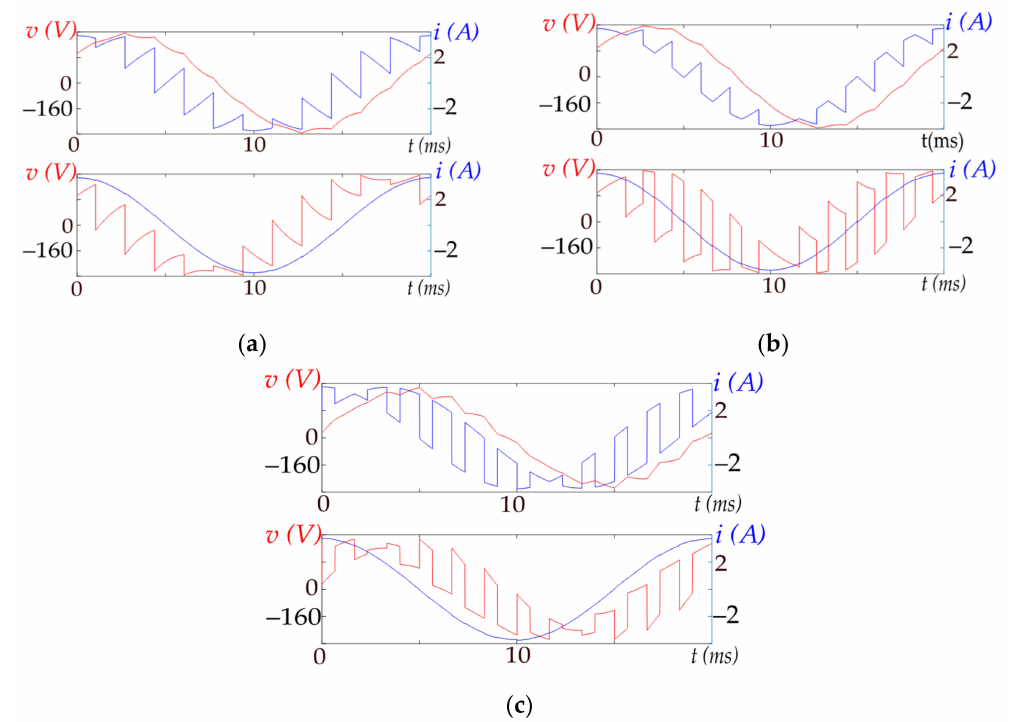
Figure 15. Simulation results for the 6 × 6 MMC structure with a 20 ◦ shift introduced. Voltage (blue) and current (red) at the output (top) and input (bottom) of the MMC: ( a ) “crossing point” approach; ( b ) “as close as possible” approach; ( c ) “two closest”